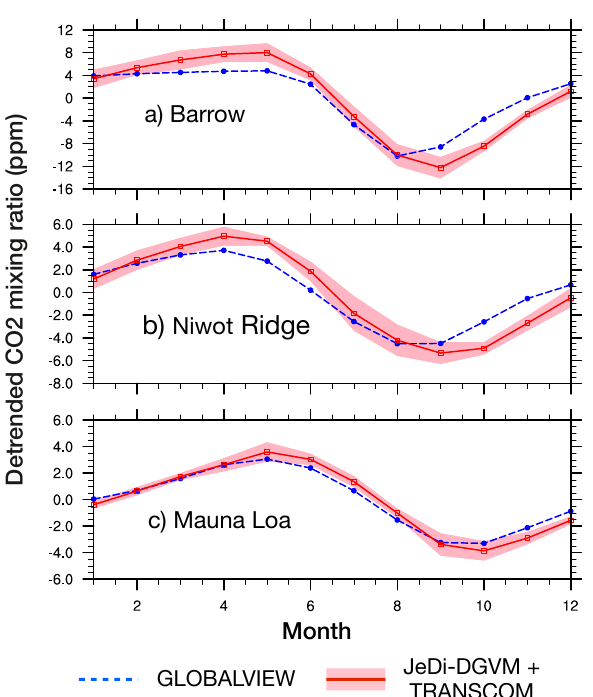
Fig. 5. Mean seasonal cycle of atmospheric CO 2 at (a) Bar- row, Alaska (71 ◦ N), (b) Niwot Ridge, Colorado (40 ◦ N), and (c) Mauna Loa, Hawaii (20 ◦ N), for years 1991–2000. The dashed blue lines represent the observations from the GLOBALVIEW dataset (Masarie and Tans, 1995). The JeDi-DGVM estimates were ob- tained by combining the simulated net ecosystem exchange (NEE) fluxes with the monthly impulse response functions (Gurney et al., 2004) of the 13 TRANSCOM atmospheric tracer transport models. The red line represents the mean of the model estimates. The light red shaded region represents one standard deviation around the mul- timodel